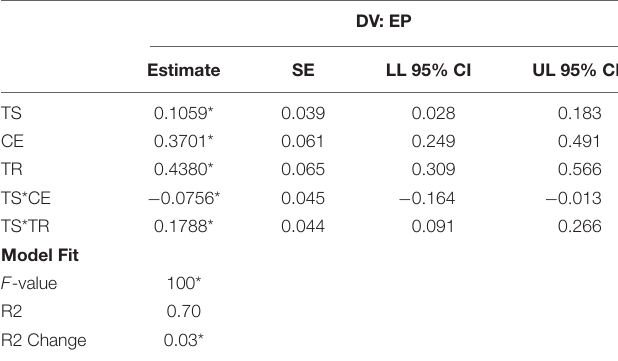
FIGURE 2 | Technostress and Creative Self-efficacy Interaction Plot. TS, Techno Stress; CE, Creative Self-efficacy; EP, Employee Performance.